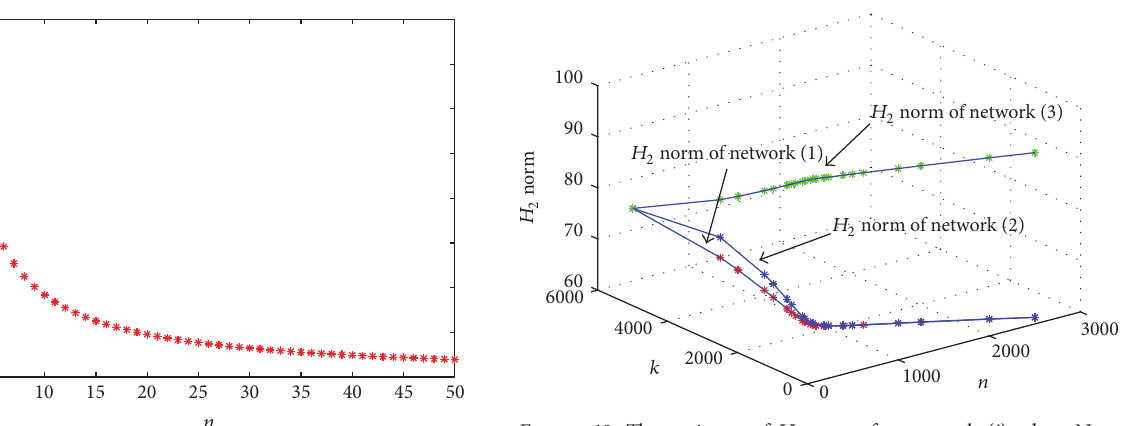
Figure 19: The variance of 𝐻 2 norm for network ( 𝑖 ) when 𝑁 = 10000 , 𝑖 = 1, 2,3 .